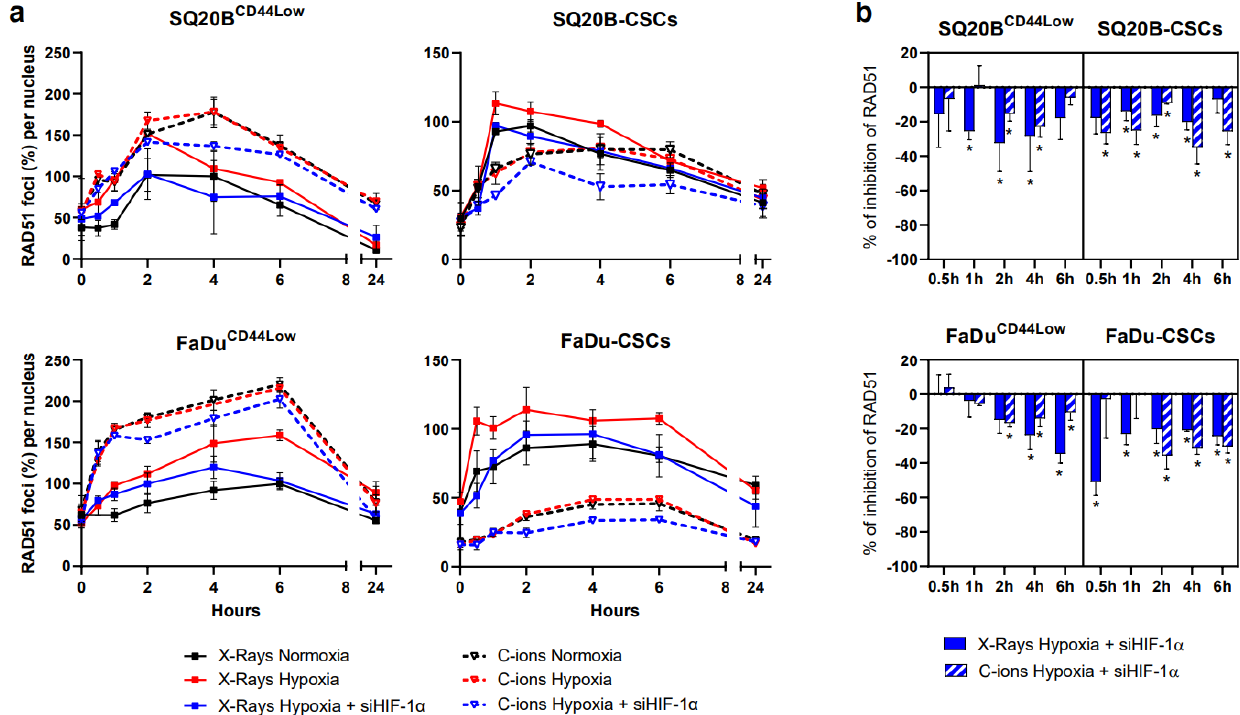
Figure 6. HIF-1 α inhibition under hypoxia decreases HR in response to photons and C-ions. ( a ) Kinetics of RAD51 foci after X-Rays and C-ions HIF-1 α ± siHIF-1 α . The percentages of foci per nucleus were reported to the reference (X-Rays-Normoxia) and calculated for each condition (means ± SD). ( b ) Effect of the silencing of HIF-1 α under hypoxia on RAD51 expression. The RAD51 percentages between hypoxia ± siHIF-1 α were statistically compared (Student’s t -Tests, Holm–Sidak method, α = 0.5) ( n = 3). * p < 0.05.